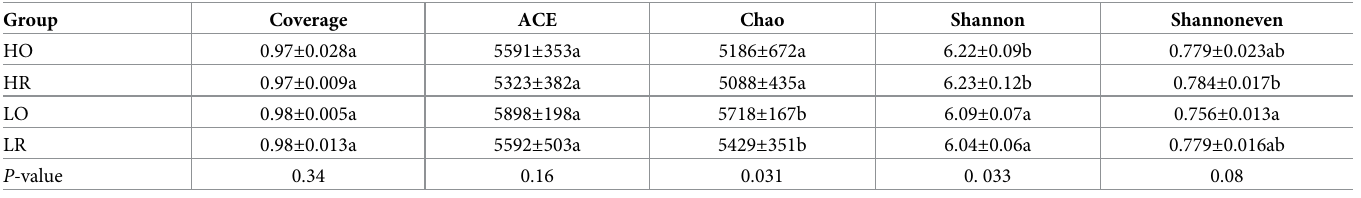
Values are mean ± standard deviation (N = 5). Values within the same column followed by different letters indicate significant difference ( P <